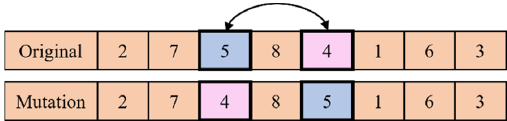
Figure 5. Mutation scheme.